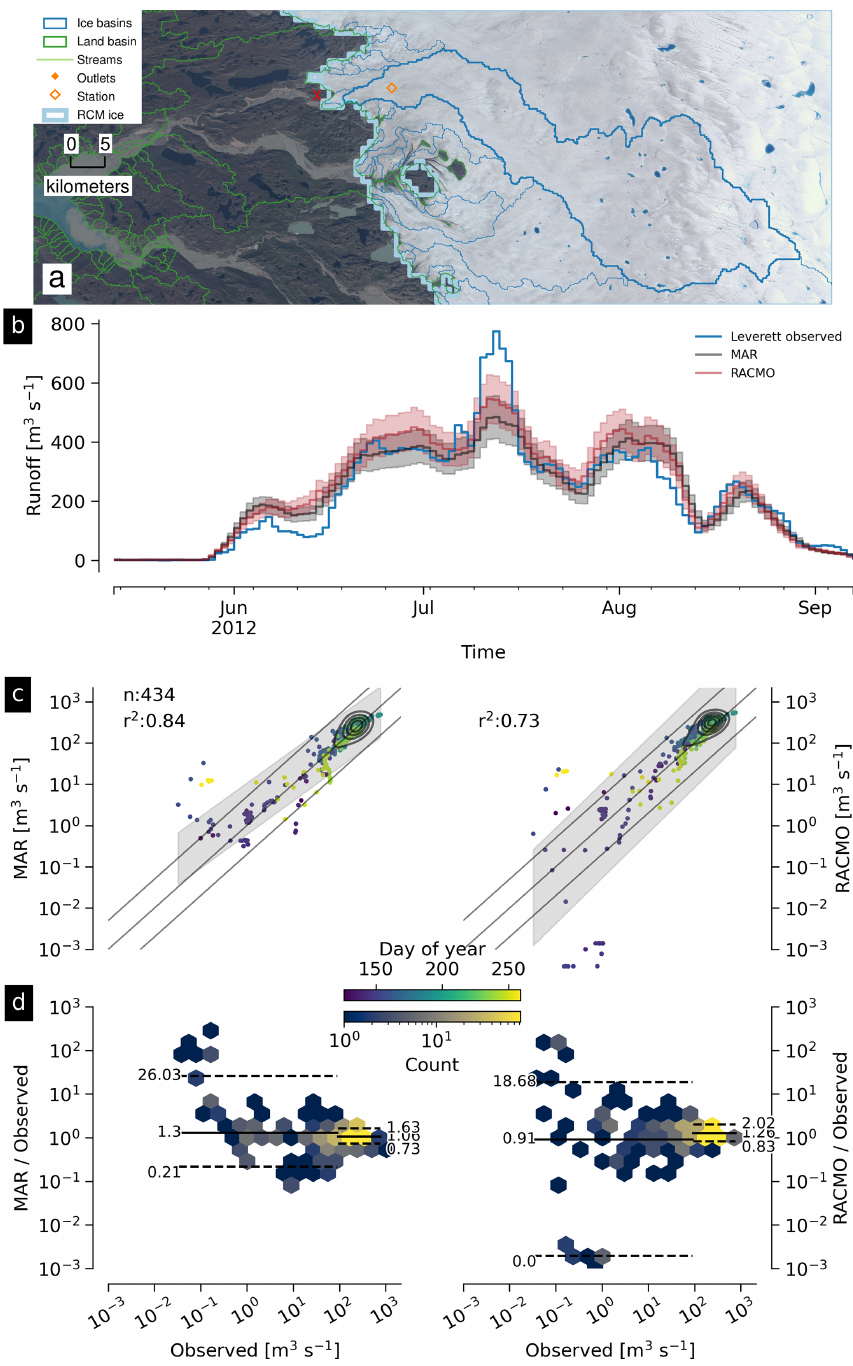
Figure 9. Graphical summary of Leverett Glacier outlet, basin, and discharge (L in Fig. 1). Red X in panel (a) marks approximate observation location, but adjusted here to an orange diamond within the ice basin. See Sect. 3.4 for a general overview of graphical elements and Sect. 4.2.3 for discussion of the Leverett Glacier basin. Basemap from Howat et al. (2014) and Howat (2017a).